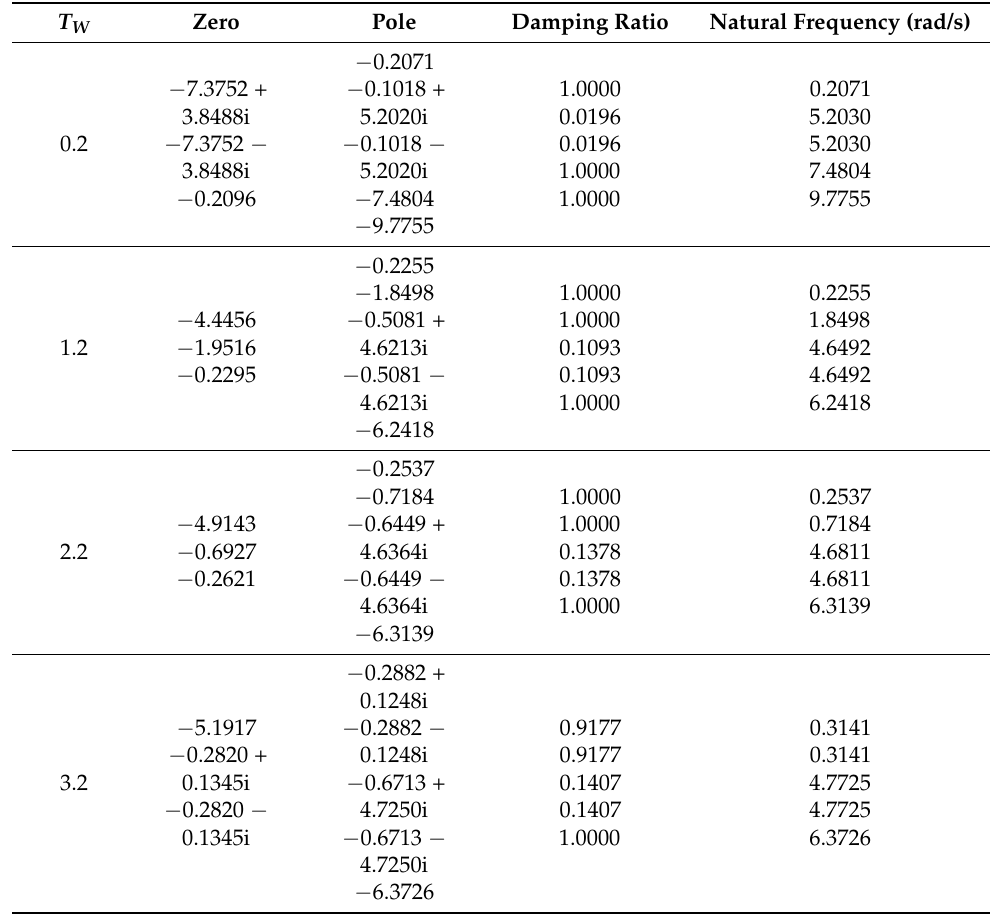
Table 4. The parameters in